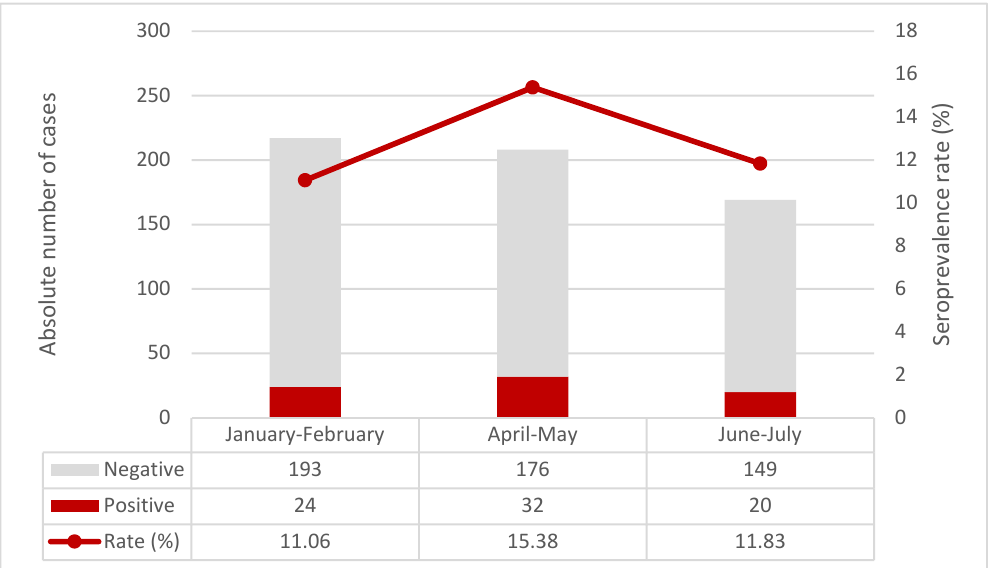
Figure 2. Seroprevalence rate over time in the three time periods.